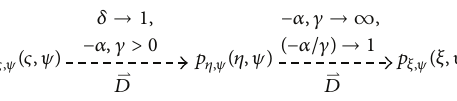
Figure 1: The relationship of the joint distributions.